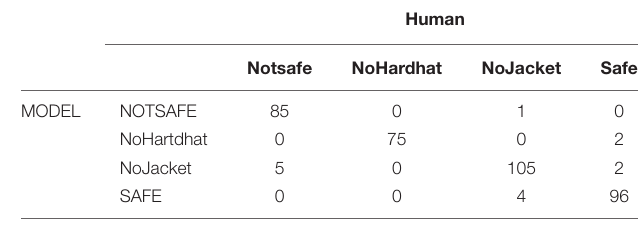
TABLE 2 | Confusion matrix for the validation